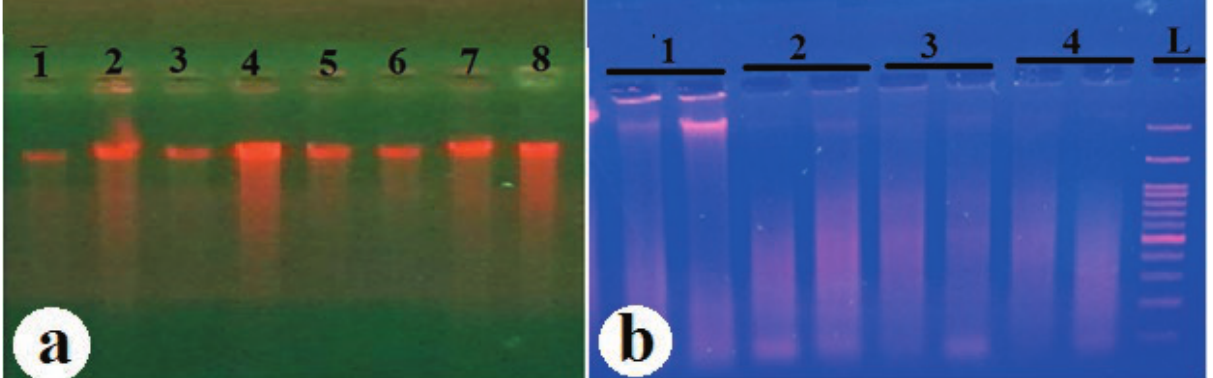
Figure 1 . Electrophoretic pattern of DNA extracted by the five different methods from Tamarix leaves. Note . The electrophoresis was per- formed in 0.8% (w/v) agarose gel. The extraction methods were: a) Nalini et al. (2003) (1- Tamarix arceuthoides 2- T. ramosissima ,3- T. chinensis , 4- T. szowitsiana , 5- T. meyeri , 6- T. androssowii , 7- T. mascatensis and 8- T. aucheriana ); b) 1- Murry and Thompson (1980); 2-